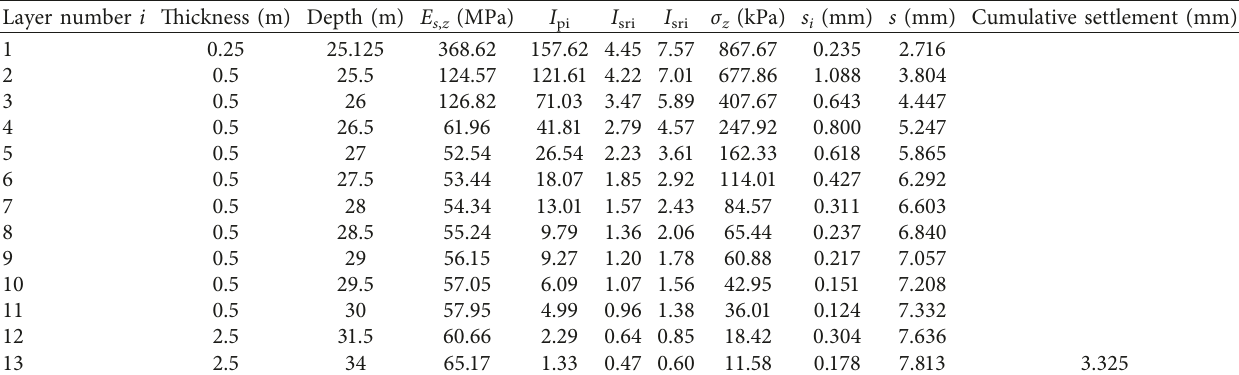
Figure 16: (a) P ∼ S curve; (b) log P ∼ log S curve. Table 7: Calculated settlement of the postgrouting pile